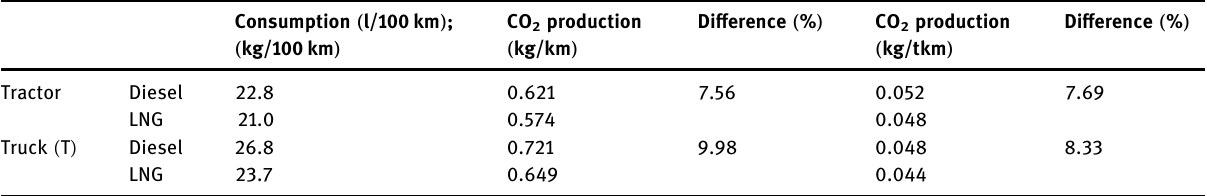
Table 4: Overall evaluation of calculations of average CO 2 production Consumption ( l/100 km ) ;